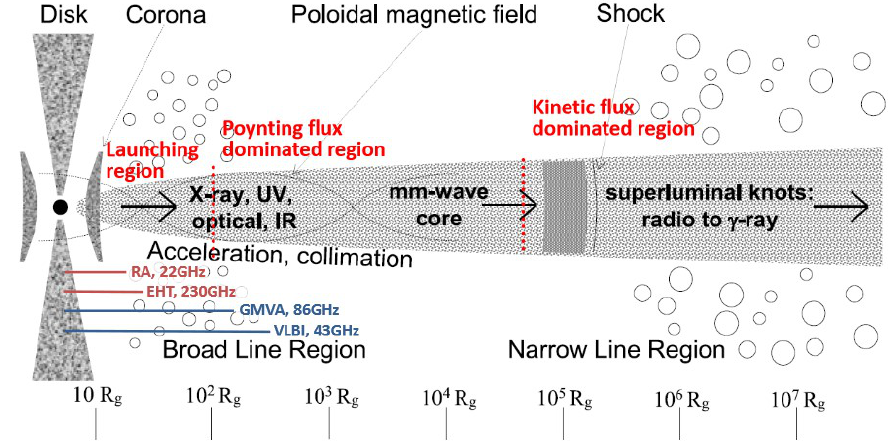
Figure 7. Innermost regions of an AGN: standard sketch of a relativistic jet, showing the launching, collimation, acceleration and beginning of propagation zones as a function of the BH gravitational radius R g . A typical resolution is given here for an AGN at low redshift, for four global and space (RadioAstron) VLBI networks at different frequencies, illustrating the possibility to well explore the jet collimation and propagation at the multi-parsec scale, and to probe even into the jet launching region far below the parsec scale, depending on the opacity in the jet and surroundings. Taken from